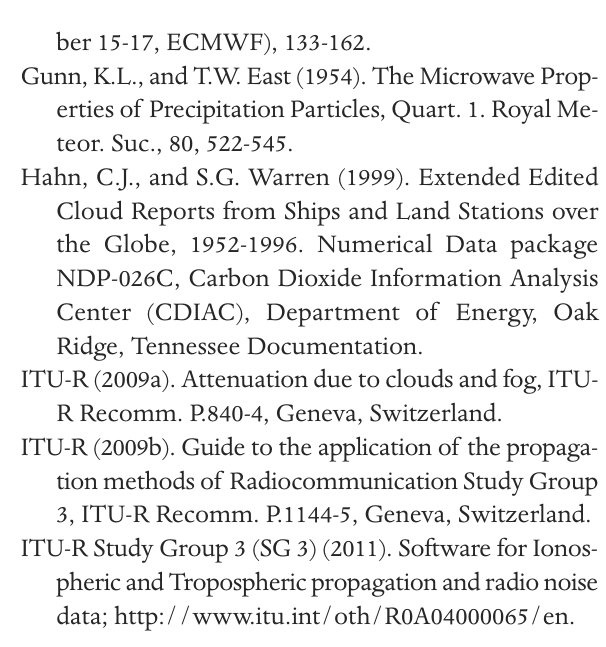
Table 5. Specific cloud attenuation at various frequencies for the six climatic